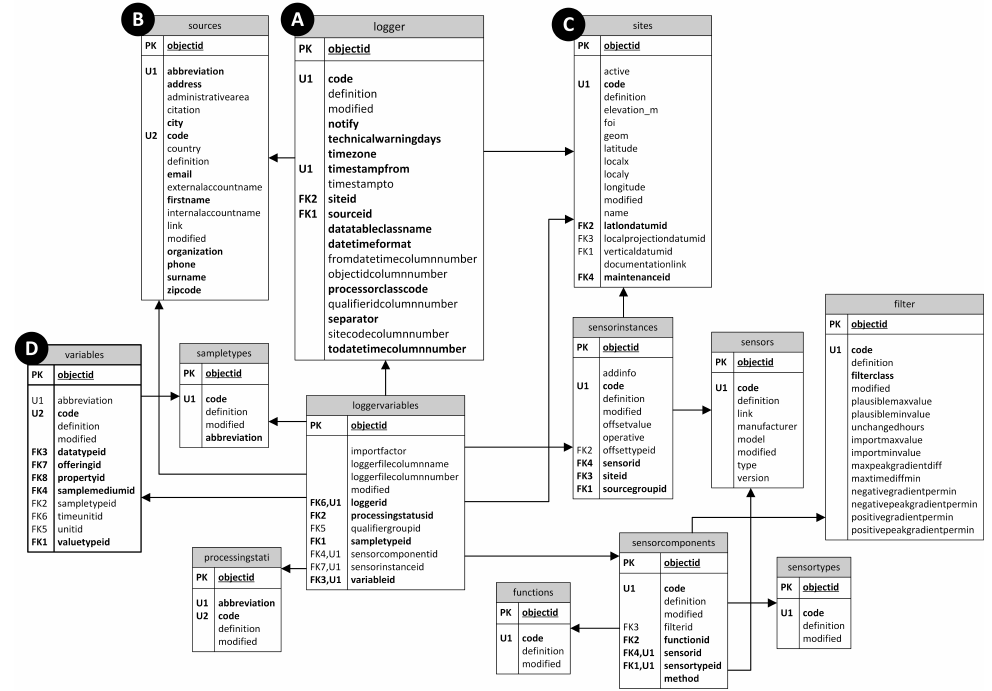
Figure 3. A sensor may have one or more sensorcomponents . For a given sensor , several instances of the sensor can be created. The instances of the sensor is associated with a specific site (station). A logger is an instrument connected to the real sensor that collect observation data over time. The information specified in tables logger and loggervariables are used by the input data parsers (Figure 1) for importing data into the data infrastructure.